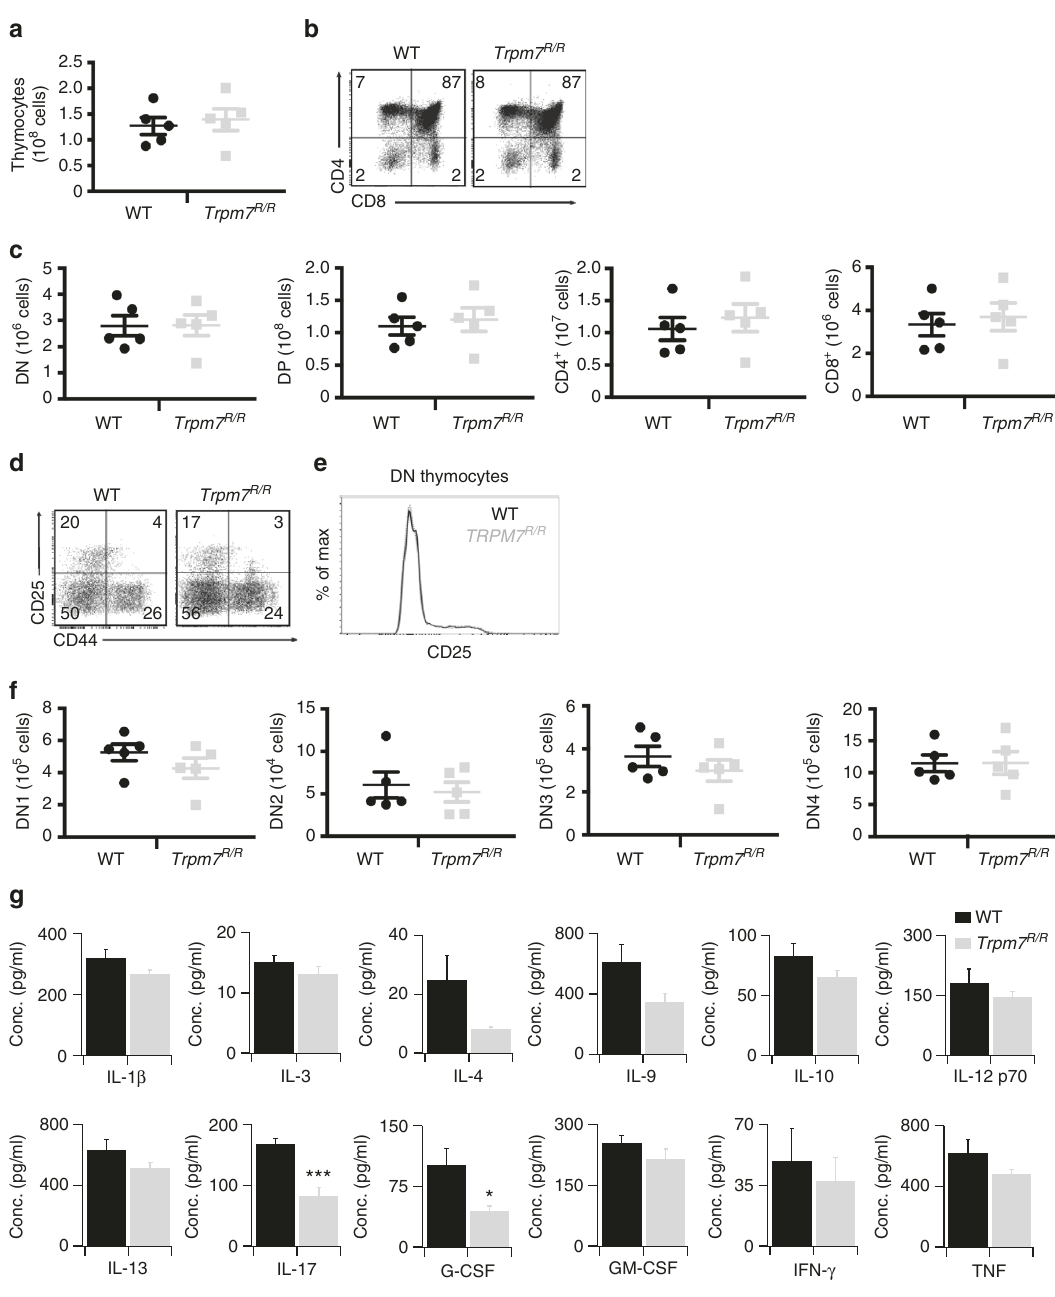
Fig. 1 Normal T cell development in Trpm7 R/R mice but altered cytokine secretion. a Total WT or Trpm7 R/R cell recovery from thymus. b Representative dot plot analysis of thymocytes from WT or Trpm7 R/R thymi stained with CD4 and CD8 mAbs. Percentages are shown in each gate. c Dot charts comparing the total number of thymocytes in the double-negative (DN), double-positive (DP), CD4 + , and CD8 + thymocytes are shown (mean ± s.e.m. n = 5). d Representative dot plot analysis of thymocytes gated on DN cells from WT or Trpm7 R/R thymi stained with CD44 and CD25 mAbs. Percentages are shown in each gate. e Representative histogram overlay of cell surface CD25 in WT or Trpm7 R/R thymocytes. f Dot charts showing the number of total cells (mean ± s.e.m. n = 5) of DN population found in the DN1, DN2, DN3 and DN4 stages. Data are representative results of two independent experiments with fi ve mice per experiment. g Basal cytokine levels evaluated in serum of WT (black, n = 3 – 7) and Trpm7 R/R (grey, n = 3 – 7) mice, respectively, and shown as pg ml − 1 . Bar charts indicate mean ± s.e.m. A total number of seven mice were used for each genotype. Note a signi fi cant reduction of serum levels of IL-17 and G-CSF in Trpm7 R/R . A two-tailed Student ’ s t test was used with * p < 0.05; ** p < 0.01 and *** p <